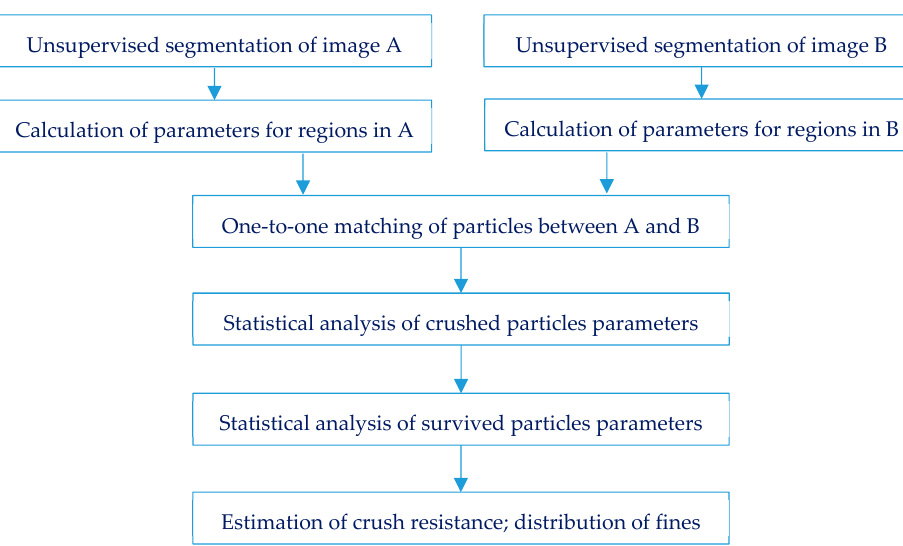
Figure 3. General data processing pipeline in a digital crush test.